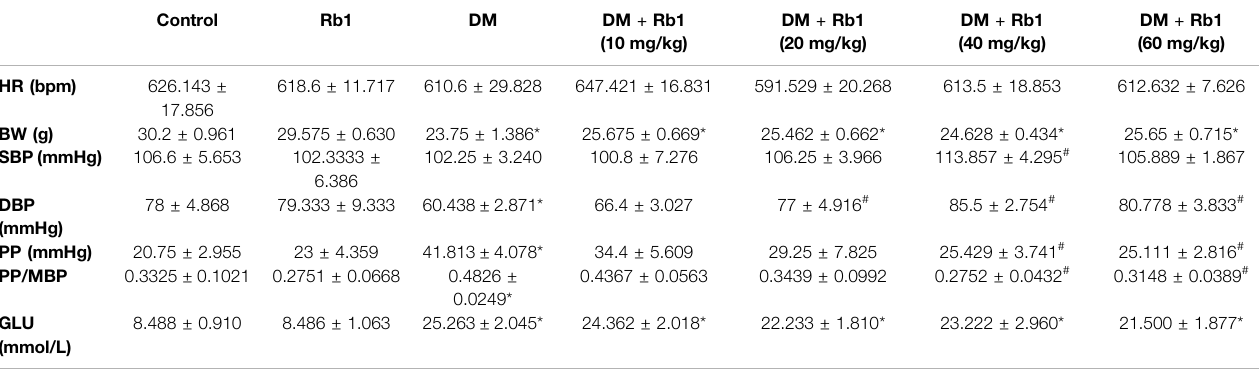
TABLE 1 | Characteristics of the mice at the end of